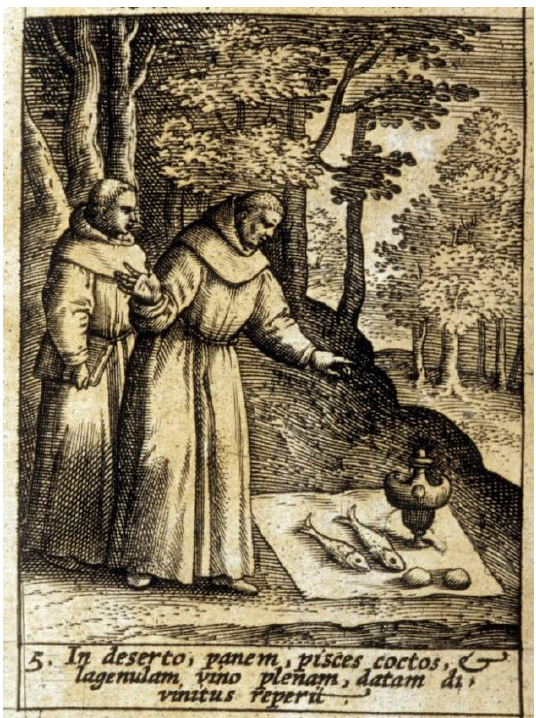
Figure 4. Adriaen Collaert (engraver) and Philips Galle (printer) after Maarten de Vos. In deserto, panem, pisces coctos, lagenulam, vino plenam, datam divinitus reperit ( In A Clearing, a Divine Gift of Bread, Cooked Fish and Wine is Discovered ), detail from S. Franciscus, S. Didacus. ca. 1600–1618. Engraving. Artwork in the public domain; image courtesy of the Biblioteca Nacional de España.